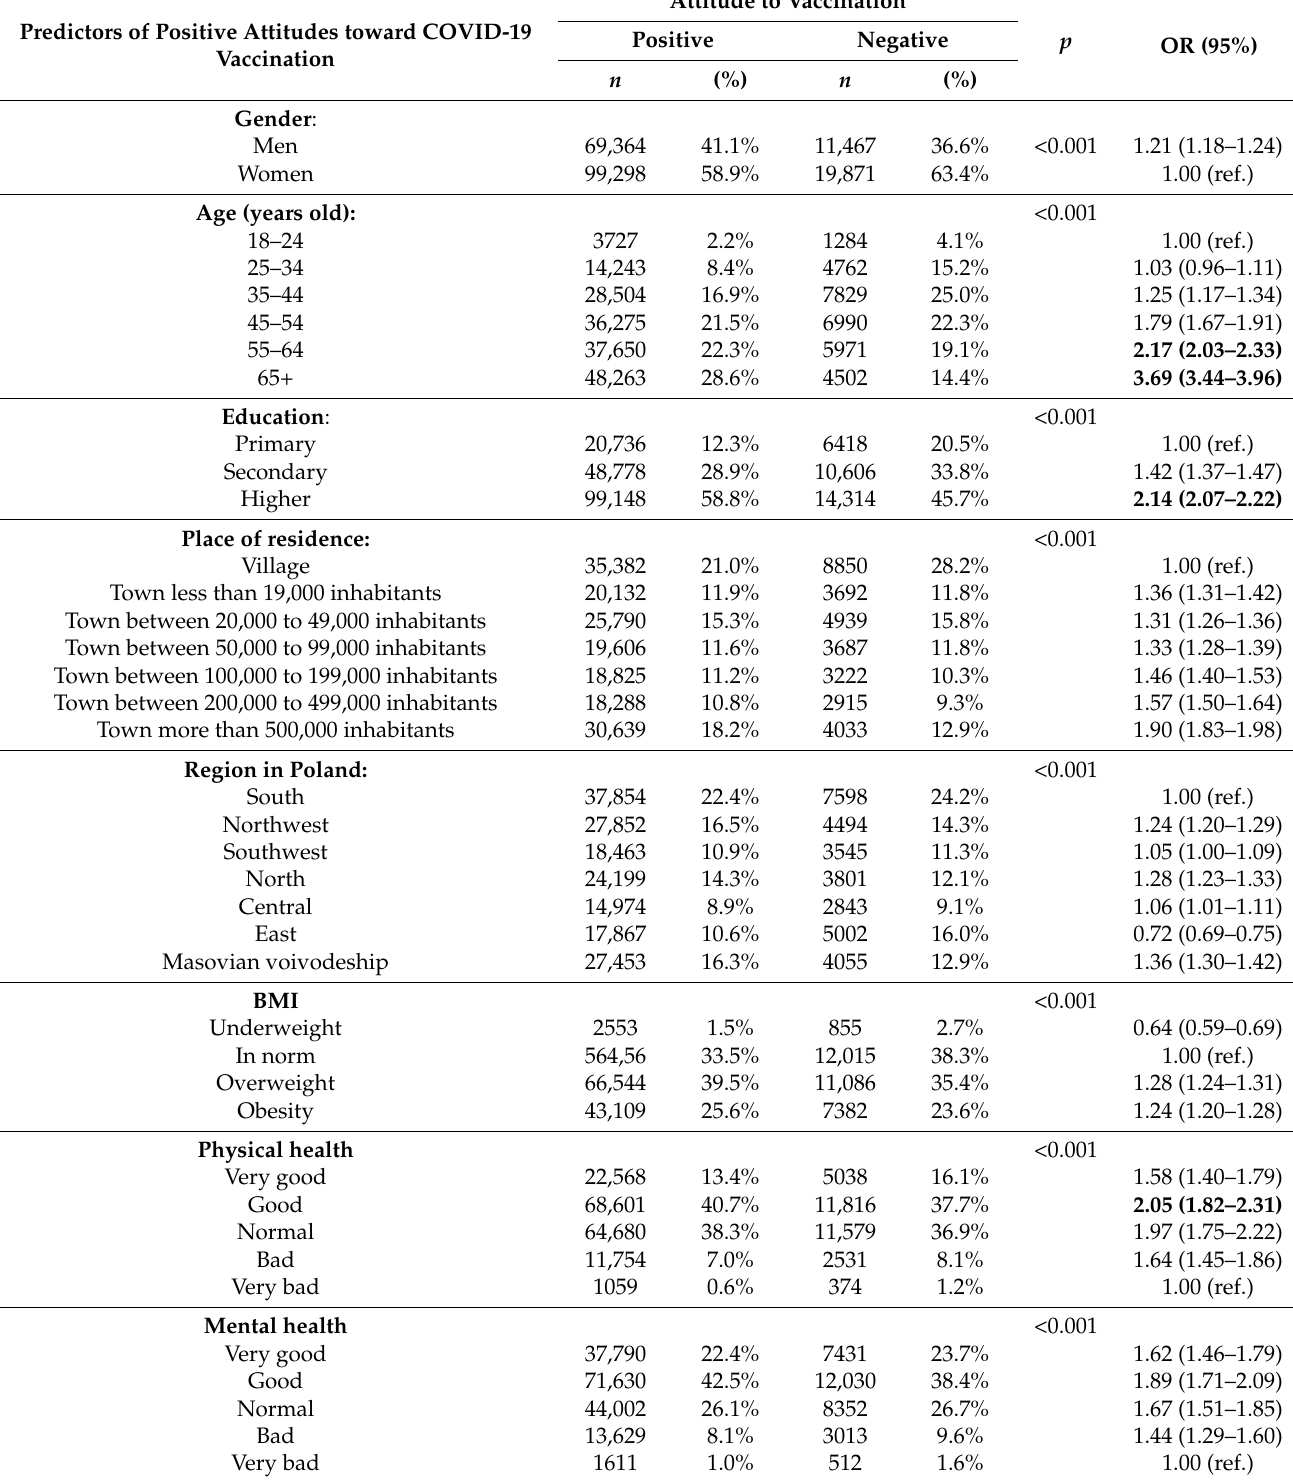
Table 3. Evaluation of positive approaches toward COVID-19 vaccination among studied respondents characterizing different sociodemographic factors (odds ratios higher than 2 were